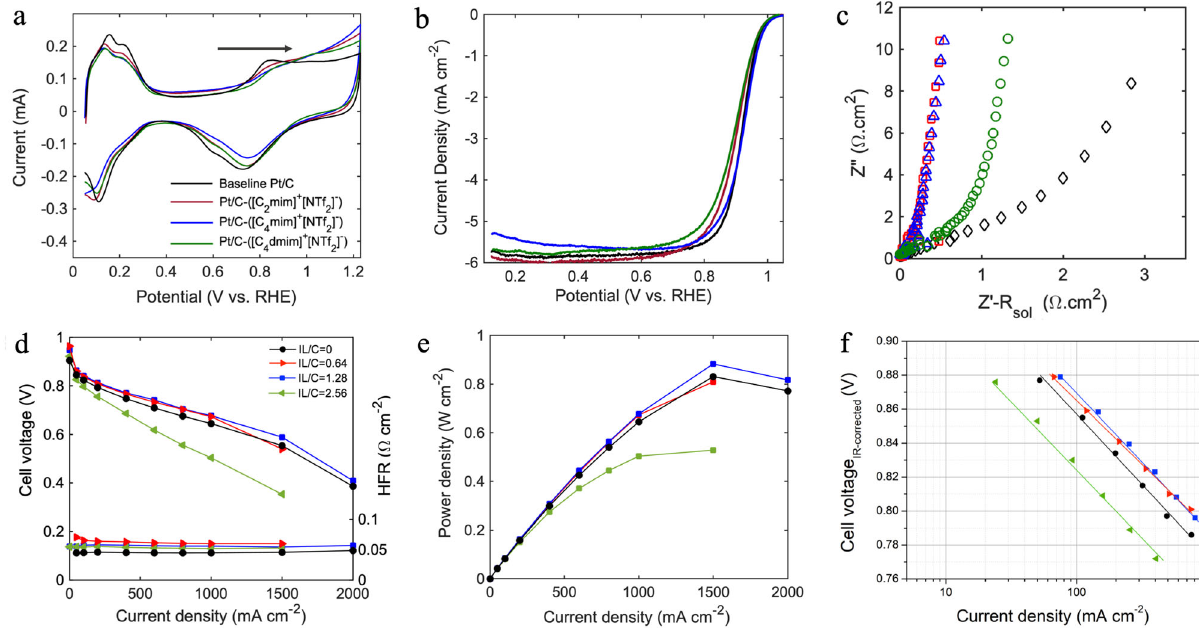
Fig. 3 | Electrochemical characterization of baseline Pt/C vs. IL-modi fi ed Pt/C 1600 rpm. c Nyquist plots of impedance spectra under N 2 -saturated 0.1M HClO 4 samples in rotating disk electrode setup and IL/C ratio optimization in MEAs for Pt/C-Na fi on and Pt/C-IL-Na fi on catalyst layers. d H 2 /air polarization curves of containing various loading of 1-butyl-3-methylimidazolium bis(tri- MEAswithIL/Cratioof0.64,1.28.2.56vs.baselinePt/Cinfuelcell, e powerdensity − )evaluatedat80°Cand100%RH. fl uoromethylsulfonyl)imide([C obtained at 150 kPa abs total pressure, f H 2 /O 2 Tafel plots measured at 150 kPa abs 4 mim] + [NTf 2 ] a CyclicvoltammogramsofbaselinePt/CandIL-modi fi edPt/CinN 2 -saturated0.1M total pressure in 5cm 2 differential cells, cathode: HSA Pt/C or HSA Pt/C-IL with HClO 4 , b polarization activity in O 2 -saturated 0.1M HClO 4 at a rotation speed of loading 0.13±0.02mgcm − 2 , anode: LSA Pt/C with loading 0.1mgcm − 2